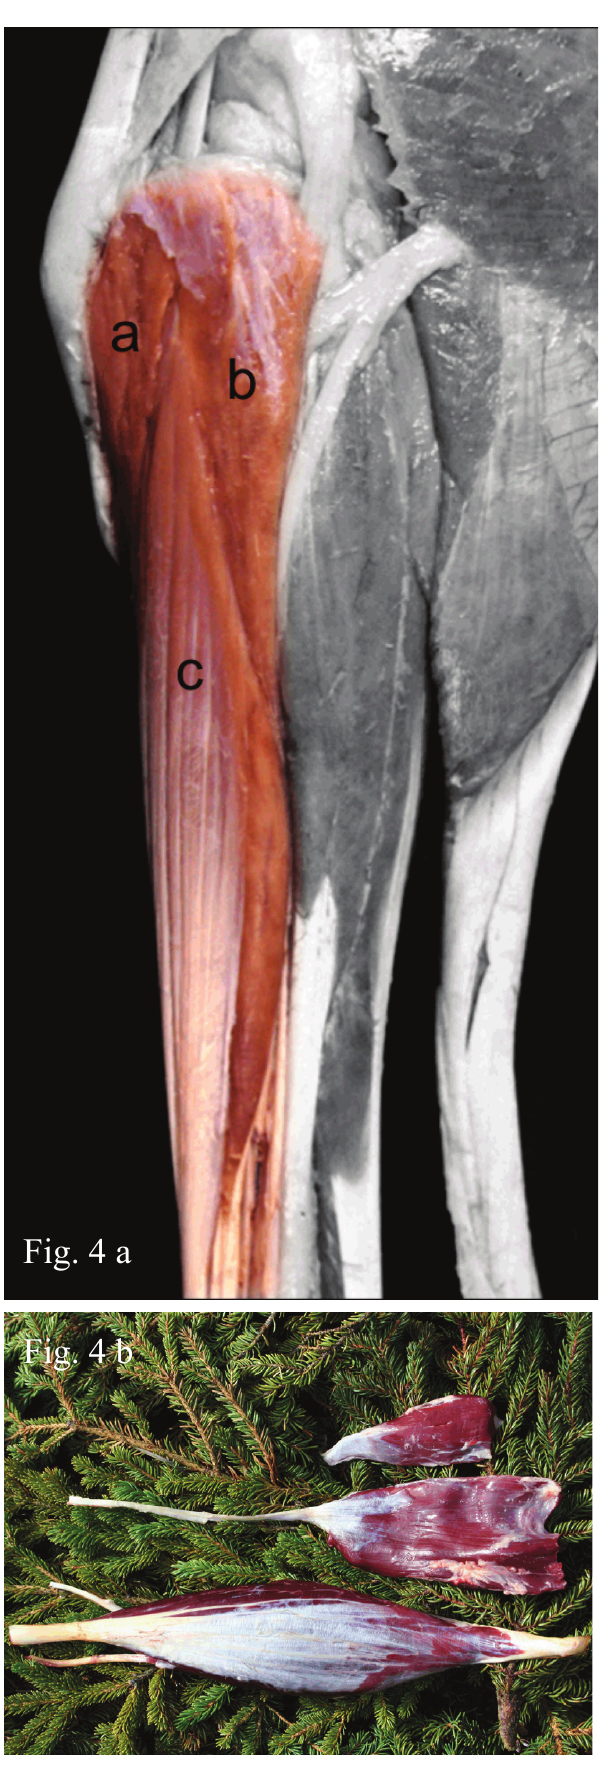
Fig. 4 The cranial crural muscle group of a caribou leg. (a) Lateral view of the hind leg showing the anatomical position of the cranial crural muscle group (spotlit). The cranial crural muscle group is composed of four muscles: a. the cranial tibial (tibialis cranialis), b. the long fibular (fibularis longus), and c. the fused third fibular (fibularis tertius) and long extensor (extensor digitorum longus). When consulting standard veterinary anatomy texts, the reader should be aware that fibularis and peroneus are syn- onyms and that both have been widely used; it has recently been agreed that fibularis should be the standard term (b) The cranial crural muscles separated. The long extensor and the third fibular are extensively fused at their upper ends and the two tendons of the long extensor are visible behind the third fibular. There is no need to separate these muscles in the field as they should all be weighed together. (Image credits: Rangifer Anatomy Project, P. Flood and C.